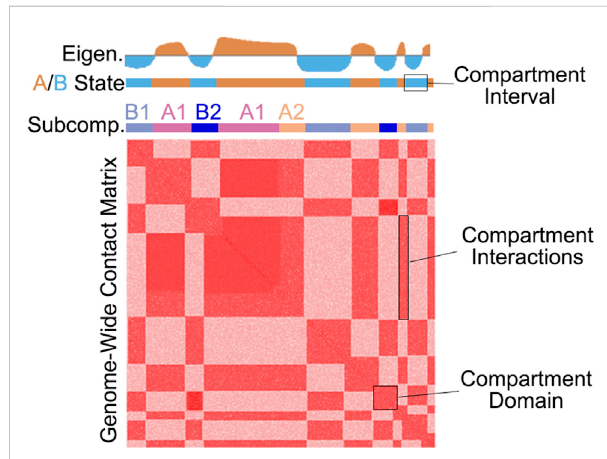
FIGURE 1 An illustration of the checkerboard pattern commonly found by whole-genome chromatin conformation assays such as Hi-C and Micro-C. The toptracksillustrateanexample eigenvectoraswellas A/ B and subcompartment classi fi cation.